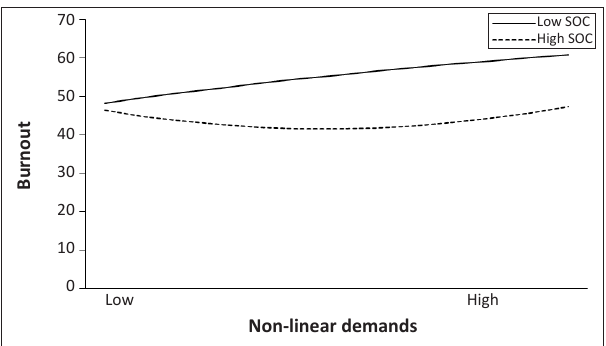
Non-linear FIGURE 3: Moderating effect of sense of coherence on the relationship between non-linear demands and burnout.